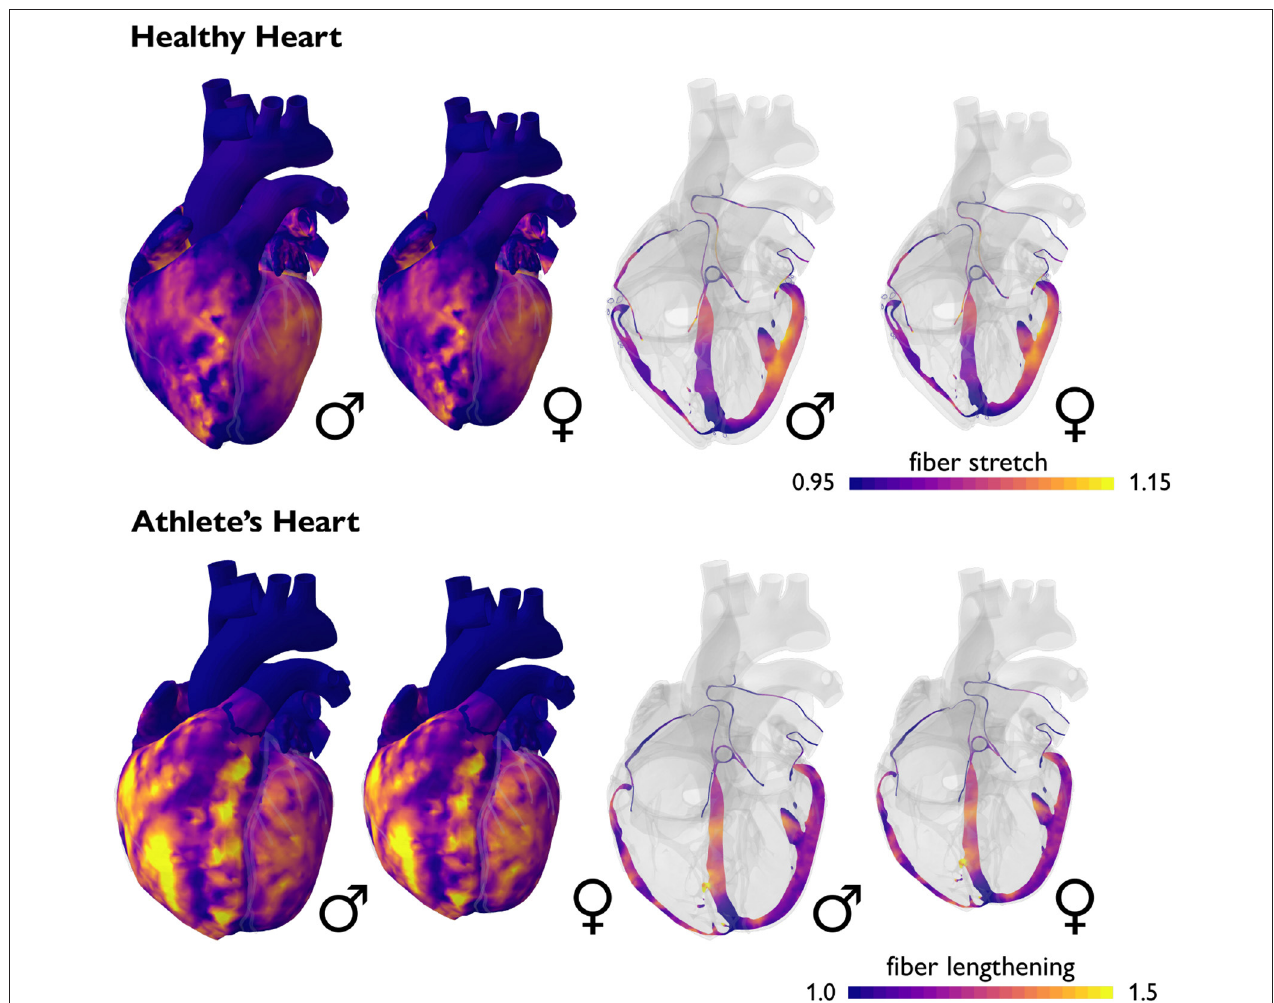
FIGURE 7 | Sex differences in long-term fiber lengthening and adaptive growth. Simulated long-term fiber stretch for male and female hearts, left and right, subject to the stroke volumes of healthy and athlete’s hearts, top and bottom. In the healthy heart, fiber stretches remain well within the physiological regime of 1.10 to 1.15, with a few local peaks on the order of 1.20. In the athlete’s heart, chronically elevated fiber stretches trigger a chronic fiber lengthening of up to 1.50. Volume overload on the whole heart level induces an overstretch on the cellular level and triggers physiological adaptation in the athlete’s heart. Male and female hearts respond similarly under both healthy and athletic